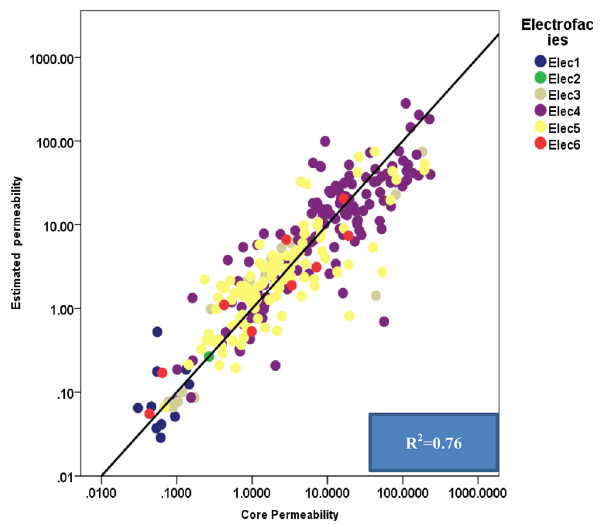
Fig. 25 Cross plot of results from estimated permeability by fuzzy logic without feature engineering versus core